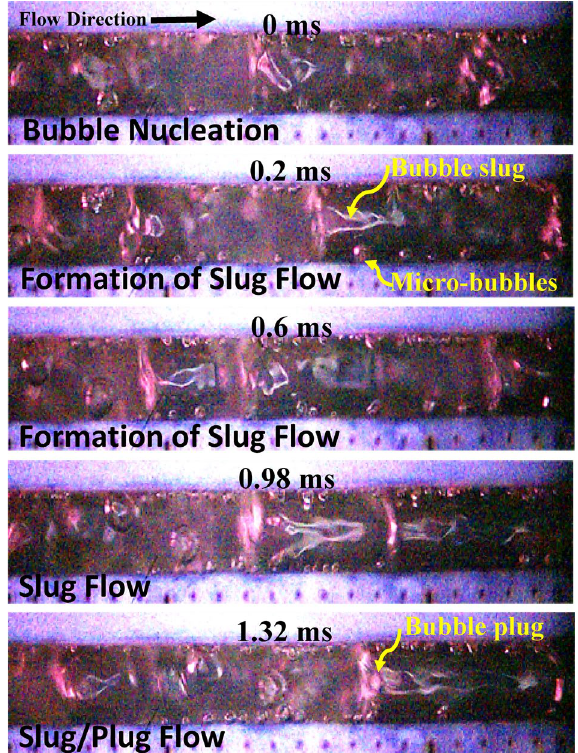
Figure 9. Flow pattern transitions of flow boiling in SiNW microchannels at mass flux, 1000 kg/m 2 s and heat flux, 48 W/cm 2 using dielectric fluid, HFE-7100 at frame rate 70,000